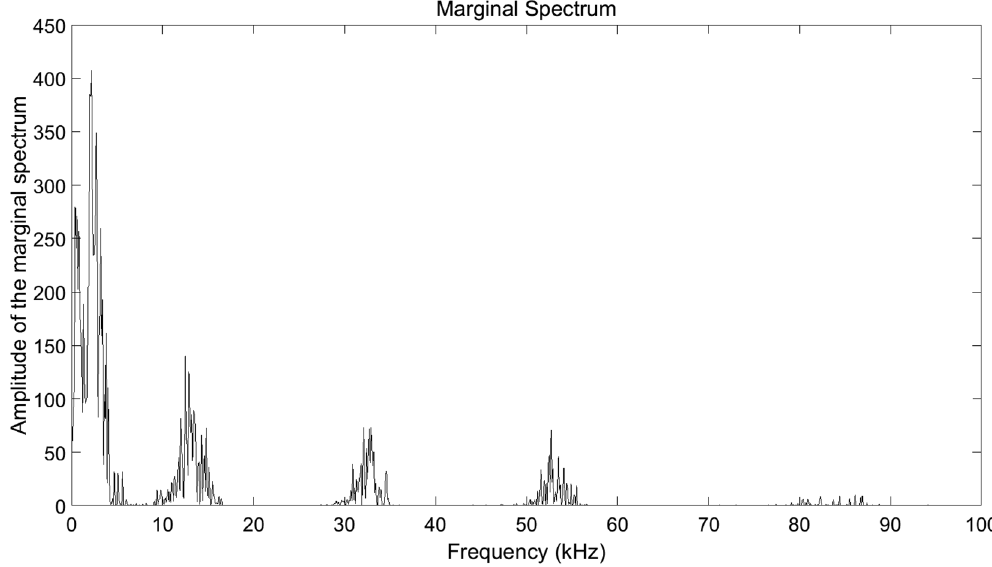
Figure 11. Marginal